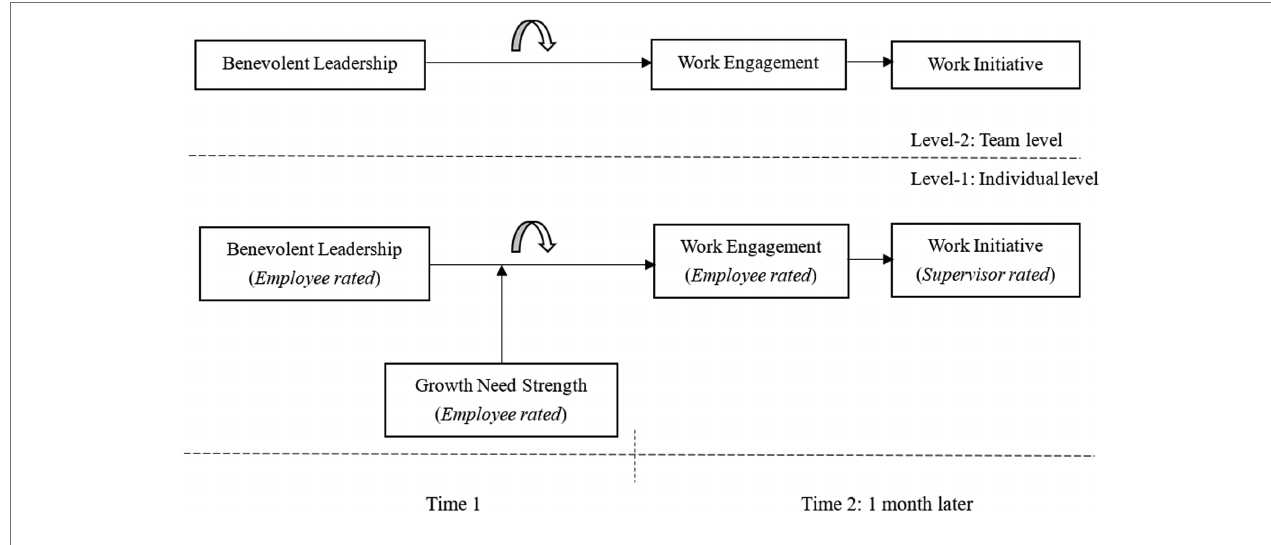
FIGURE 1 | Theoretical